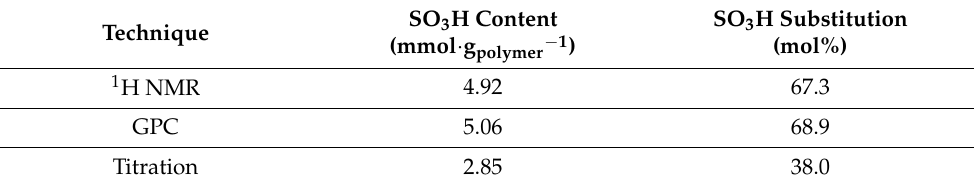
Table 2. Calculated sulfonation content of poly(2,4-dihydroxy-5-sulfobenzoic acid) through titration, GPC, and 1 H NMR.